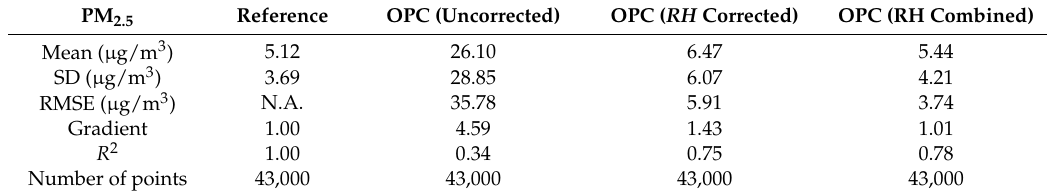
Table 6. Statistical parameters for PM 2.5 measurement of reference, uncorrected OPC, and OPC after the application of the RH